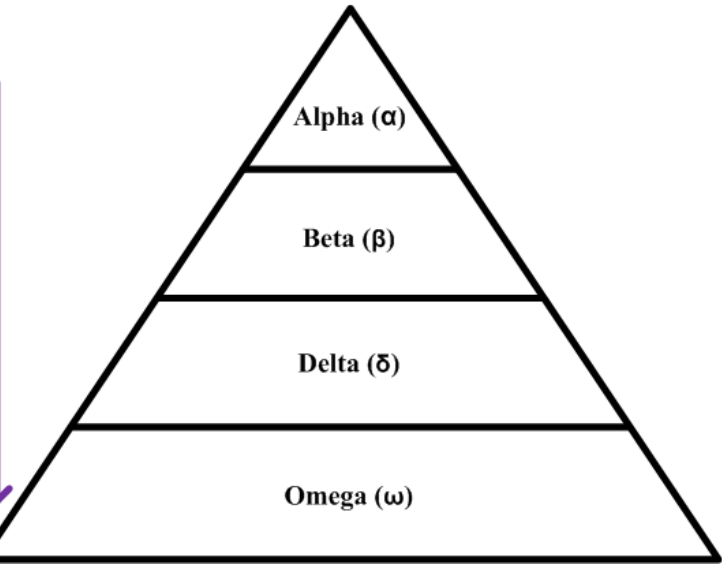
Figure 4. Hierarchy of the grey